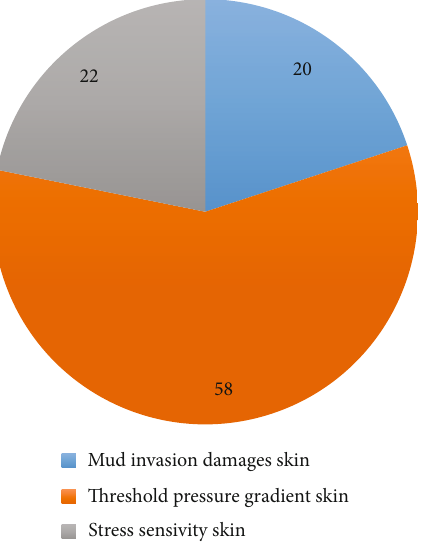
Figure 19: Factors a ff ecting the XJX-2Sa well.